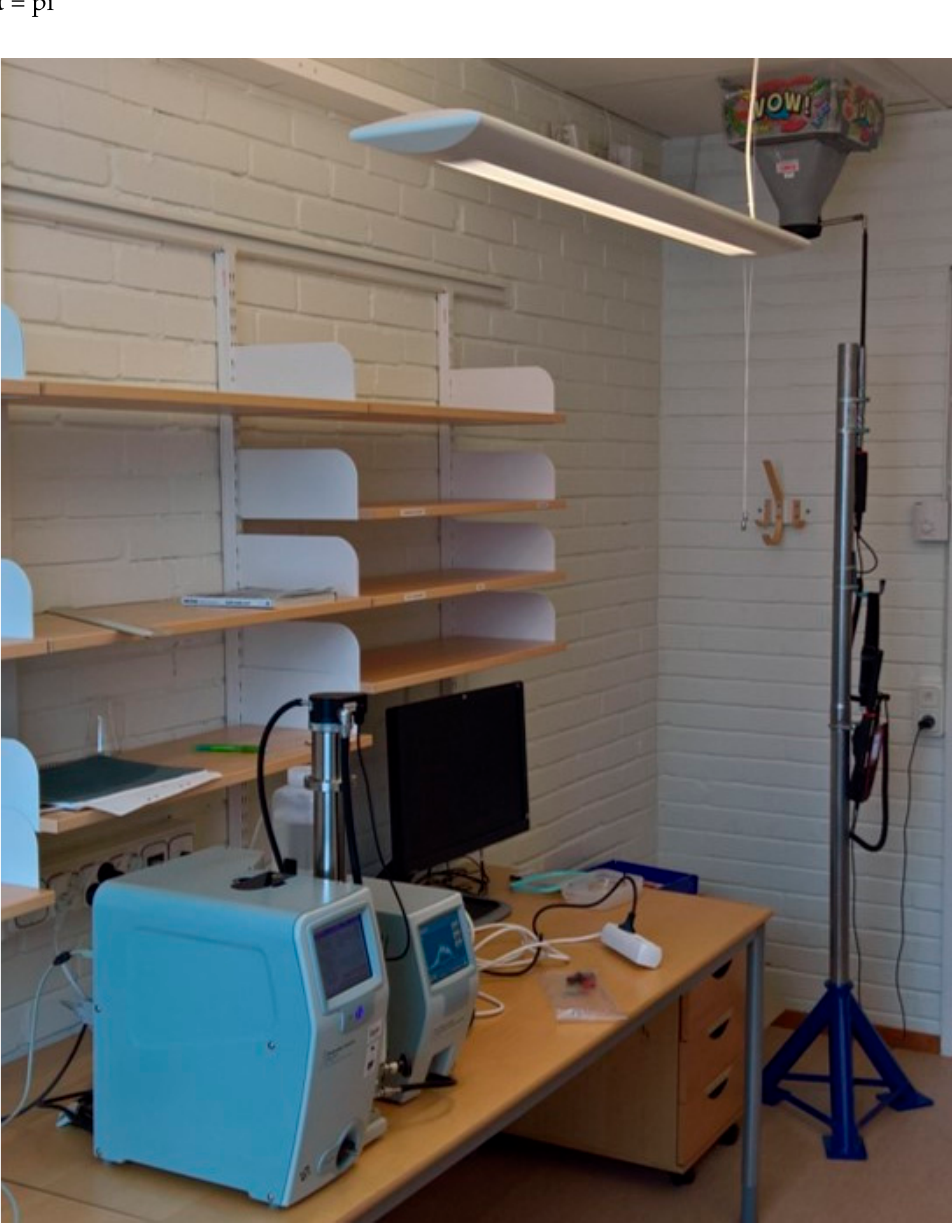
Figure 2. Measurement of nanoparticles indoors with SMPS 3938 ( left ) and ventilation flow with AMI310 ( right ).